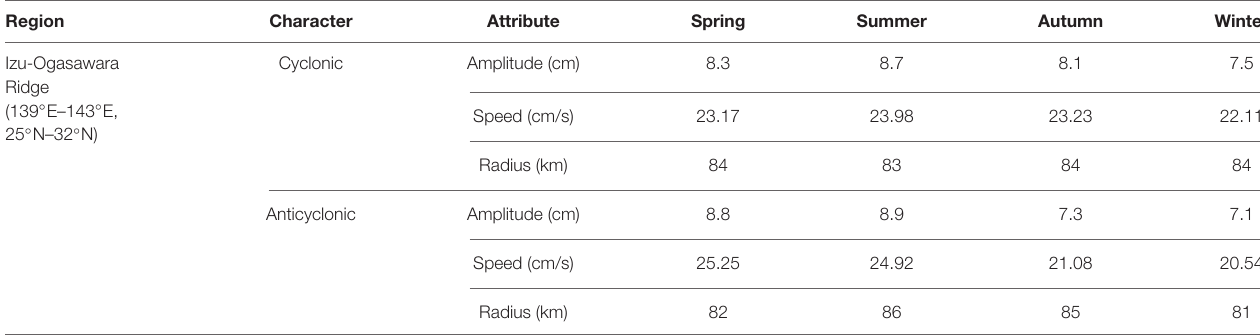
TABLE 3 | Seasonal and polarized statistics of all mesoscale eddies in the ridge region (130 ◦ E–170 ◦ E, 20 ◦ N–35 ◦ N) from 1993 to 2018.